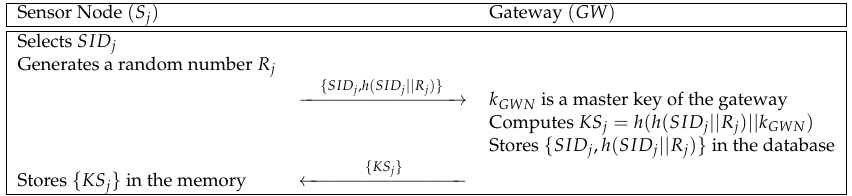
Figure 5. Sensor node registration phase of a secure and lightweight mutual authentication protocol (WSN-SLAP).